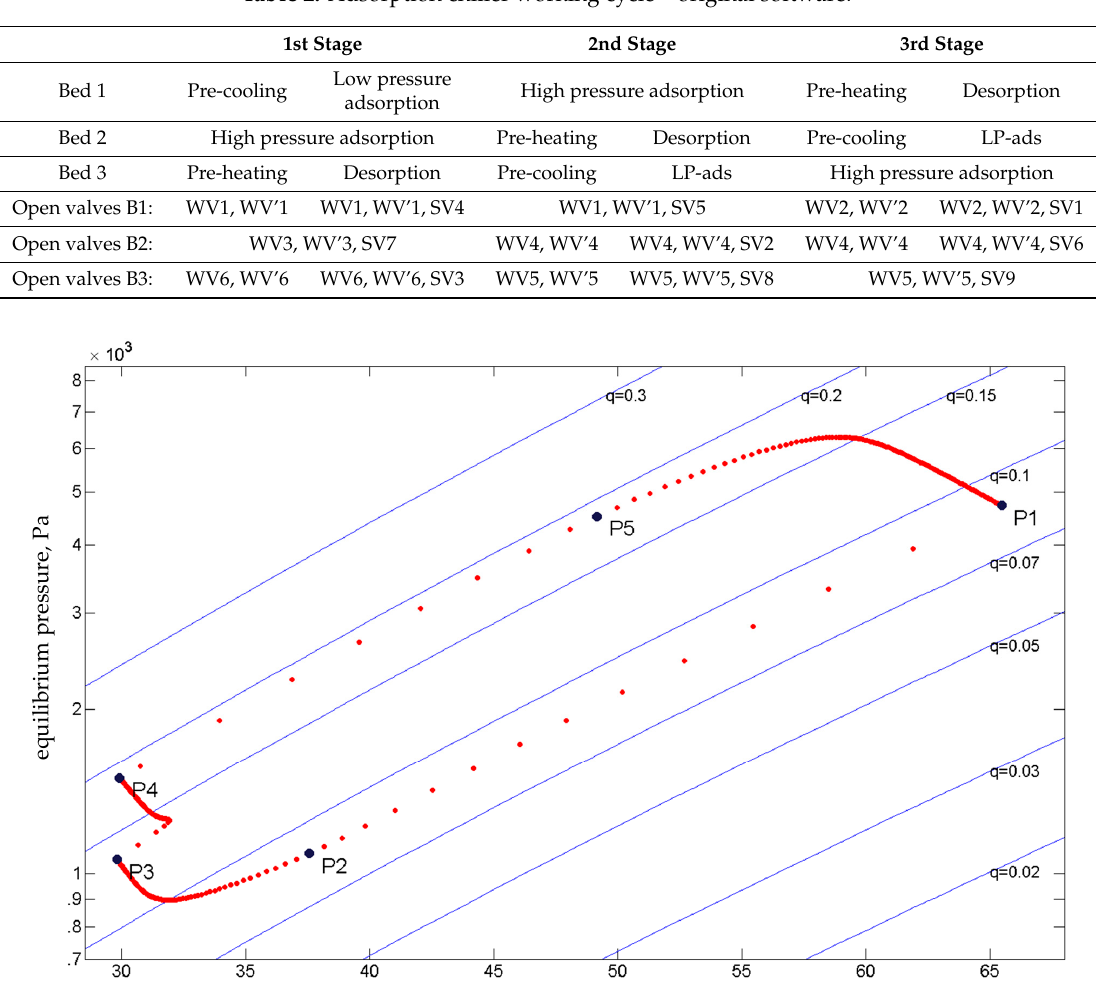
Table 2. Adsorption chiller working cycle—original software.